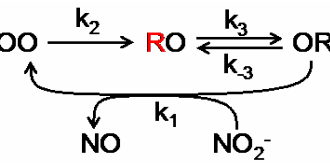
Scheme 1. Scheme the catalytic cycle of NiR. The possible combinations of redox states of the T1 and T2 Cu centers are represented by OO (both oxidized), RO (T1 reduced, T2 oxidized) and OR (T1 oxidized, T2 reduced). The unquenched state is in red (T1 reduced). The external electron donor has been omitted from the first reduction step.